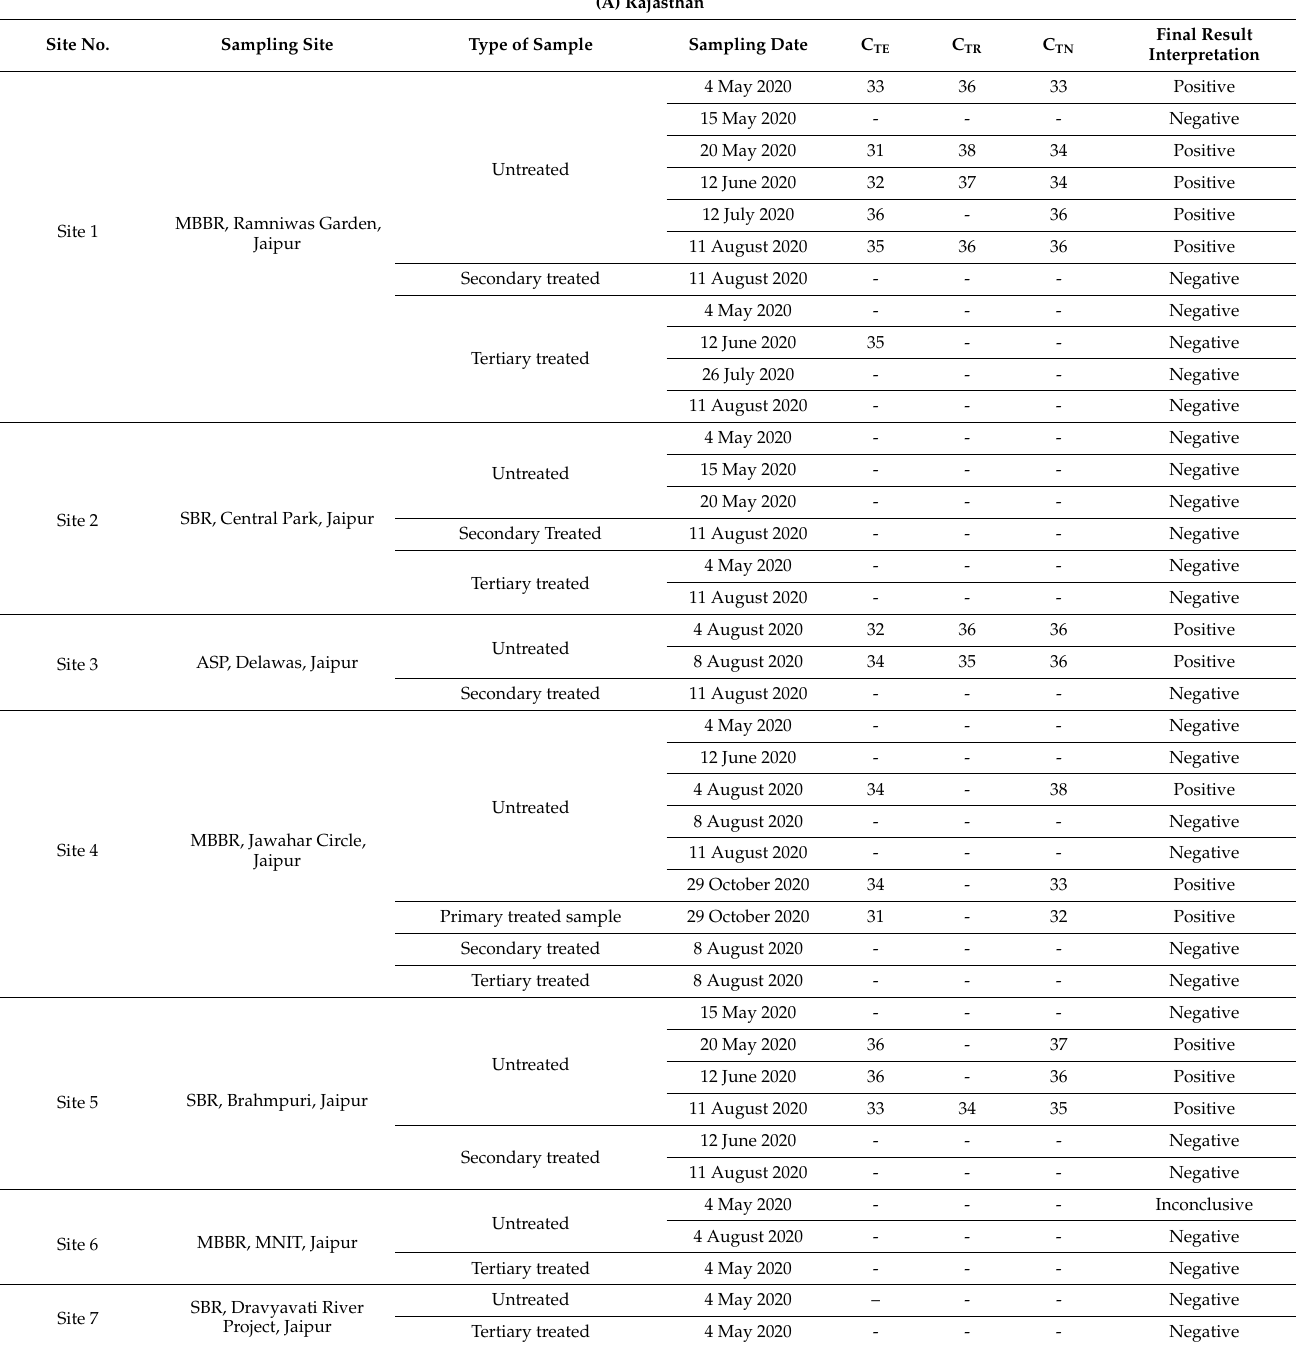
Table 2. Table 3. Results showing Ct values of targeted genes for detection of SARS-CoV-2 RNA in untreated and treated wastewater samples collected from different WWTPs.